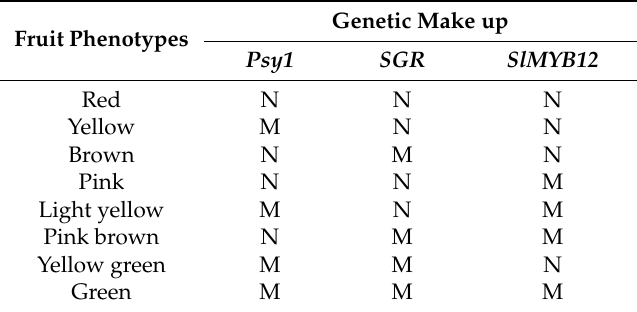
Table 1. Summary of the genetic makeup of the different fruit color phenotypes in the F 2 population for Psy1 , SGR , and SlMYB12 in tomato.